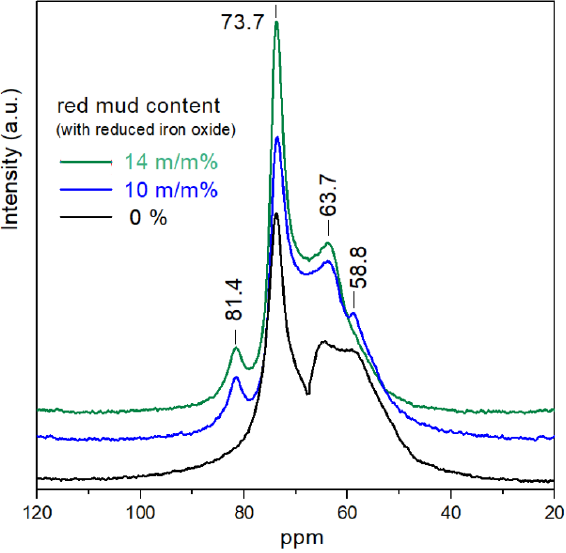
Figure 2. 27 Al MAS NMR spectra of samples heat-treated at 600 °C vs. rmr content.